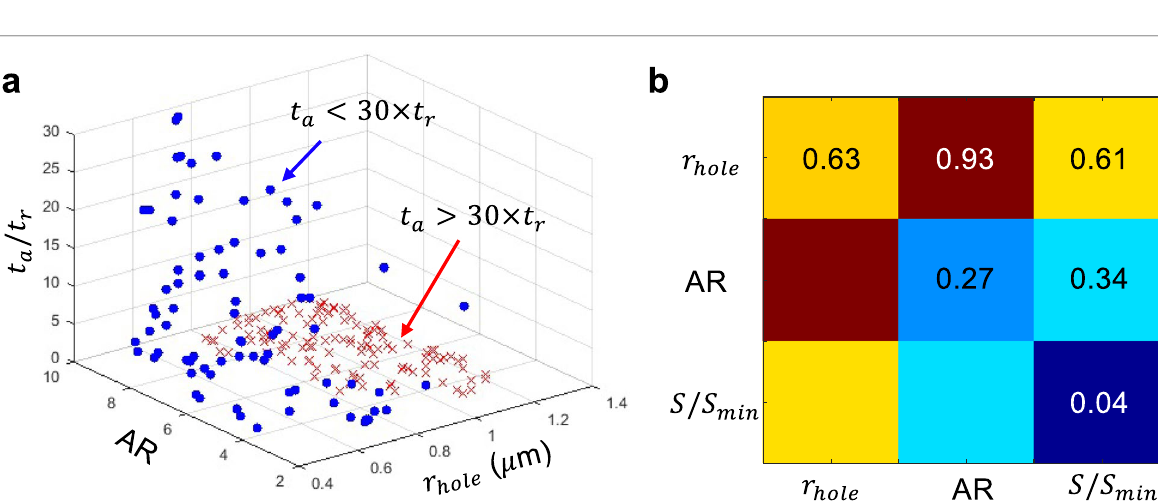
Fig. 5 Parametric study and sensitivity analysis results; a normalized annealing duration according to aspect ratio (AR) and radius ( r hole ) of holes and b sensitivity of t a to three variables [i.e., r hole , AR, and normalized spacing ( S / S min